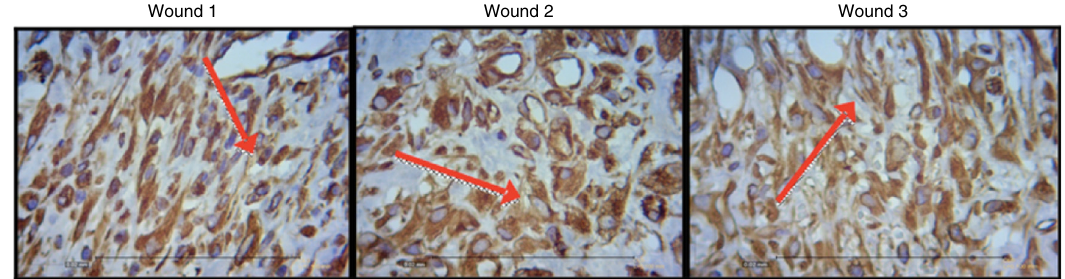
Photomicrograph of vimentin --- where macrophages, fibroblasts, and vessels are evaluated, on the seventh day of evolution, in wounds 1, 2 and 3 (VIM × 200).